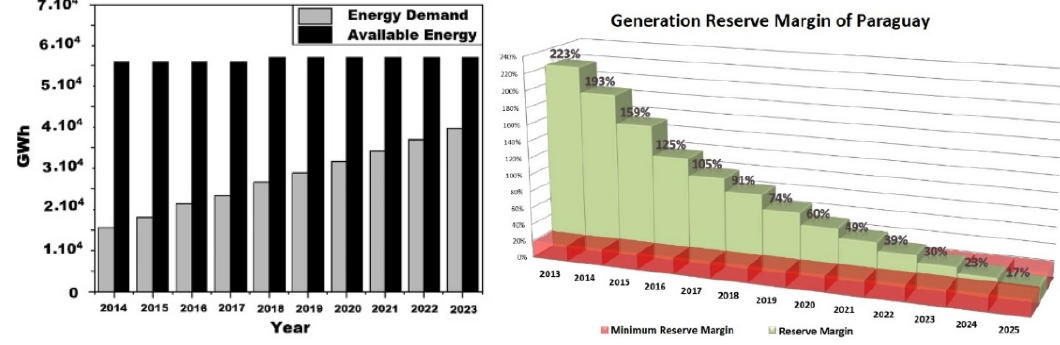
Figure 1. Energy demand vs. availability and generation reserve margin of Paraguay [28,29].